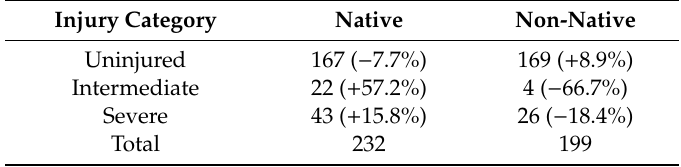
Table 6. Number of by-catch individuals (native and non-native species) in each category (uninjured, intermediate, and severe). Percentage deviations (a measure of the extent to which the observed chi-square value varies from that expected if there is no association between the variables) are